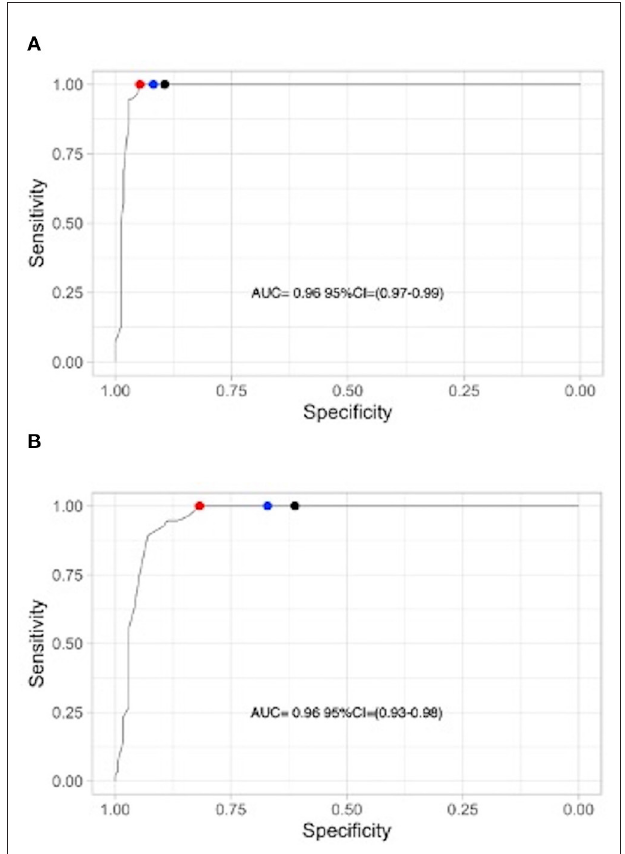
FIGURE 3 | (A) Histogram for V/Q scan interpreted on mismatched perfusion defects. (B) Histogram for V/Q scan interpreted on all segmental